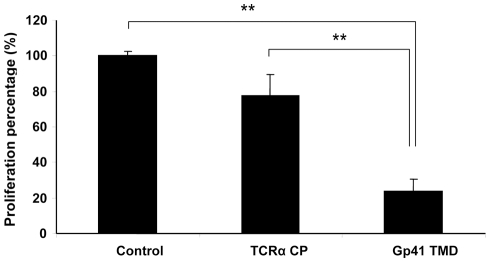
Gp41 TMD inhibit T-cell activation induced by mitogenic antibodies to CD3.T-cells were activated with 1µg/ml anti-CD3 and APC in the presence of 50µg/ml gp41 TMD or TCRα CP and the proliferative responses were assayed. The uninhibited T-cell proliferative responses were 9103±208 cpm. The background proliferation in the absence of antigen was 257±41 cpm. The data are presented as normalized mean proliferation percentage (control, no peptide = 100%) + SD (n = 5 or more, ** p<0.01). There was no significant statistical difference between the TCRα CP and the control.